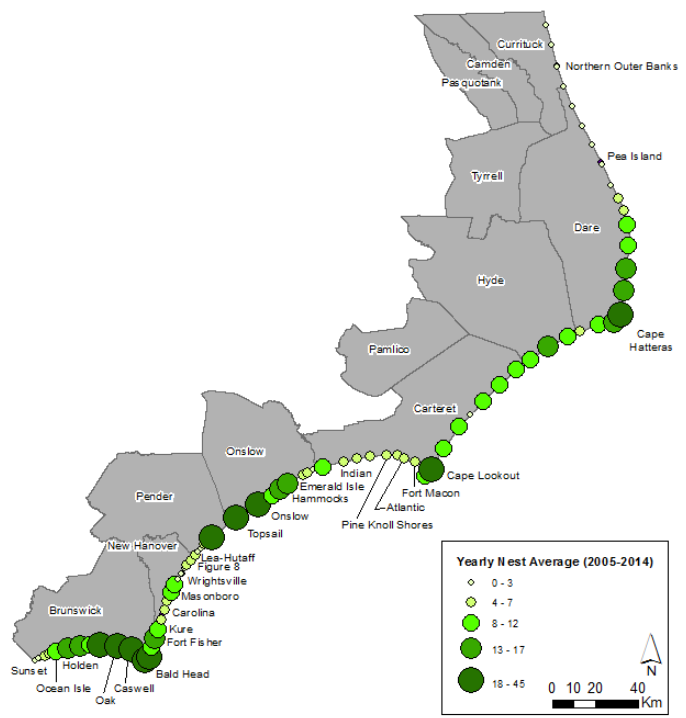
Figure 5. Average yearly number of nests by transect polygon (2005–2014).